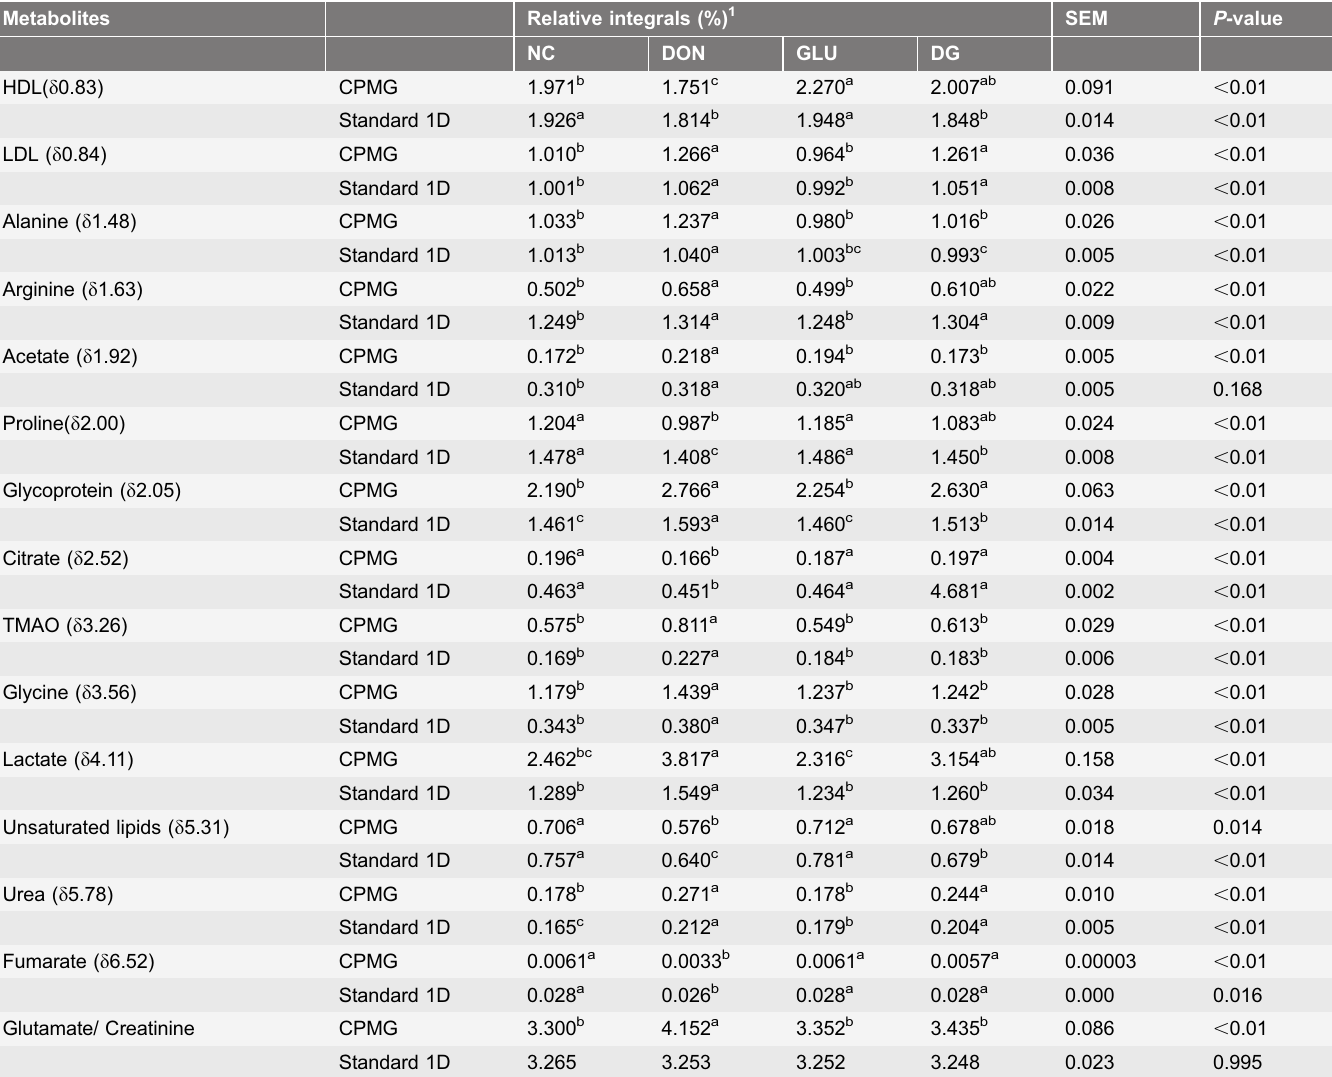
Table 4. Relative integrals (%) 1 from selected plasma metabolites in piglets of all